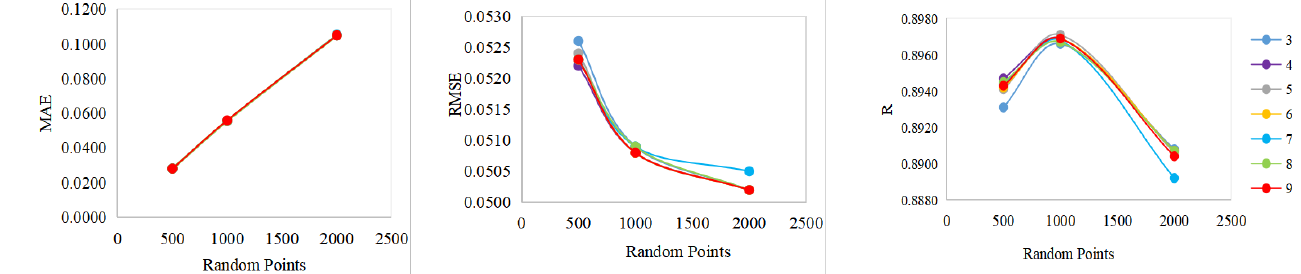
Figure 11. The MAE, RMSE, and R with different numbers of random points and hidden layers (3 to 9 are hidden layers).